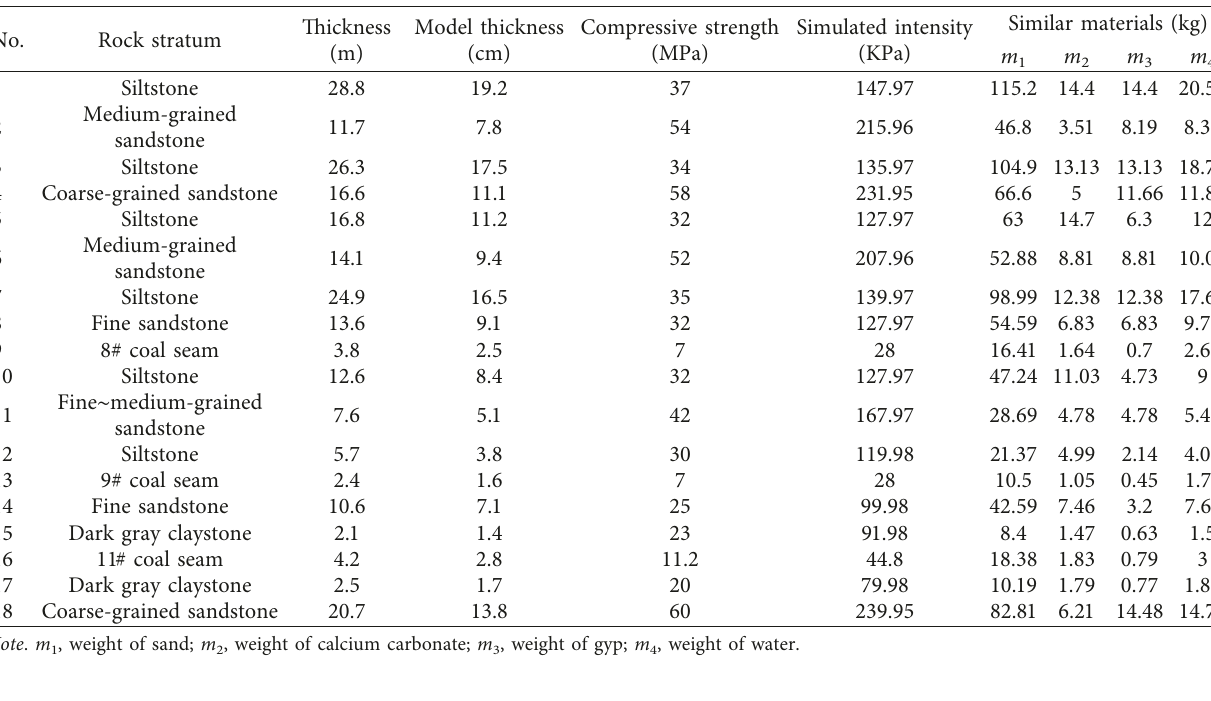
Table 2: Coal and rock parameters for physical similarity simulation experiment.